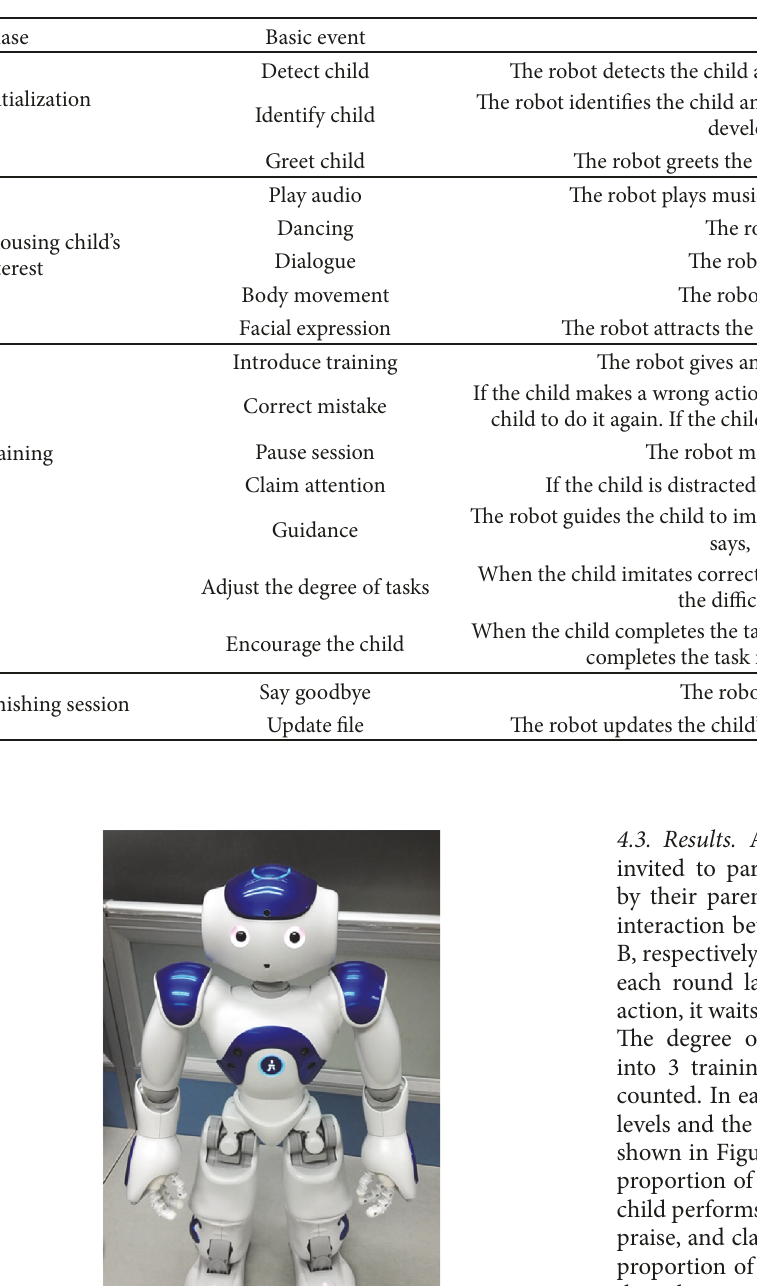
Table 2: Overview and explanation of the basic event.